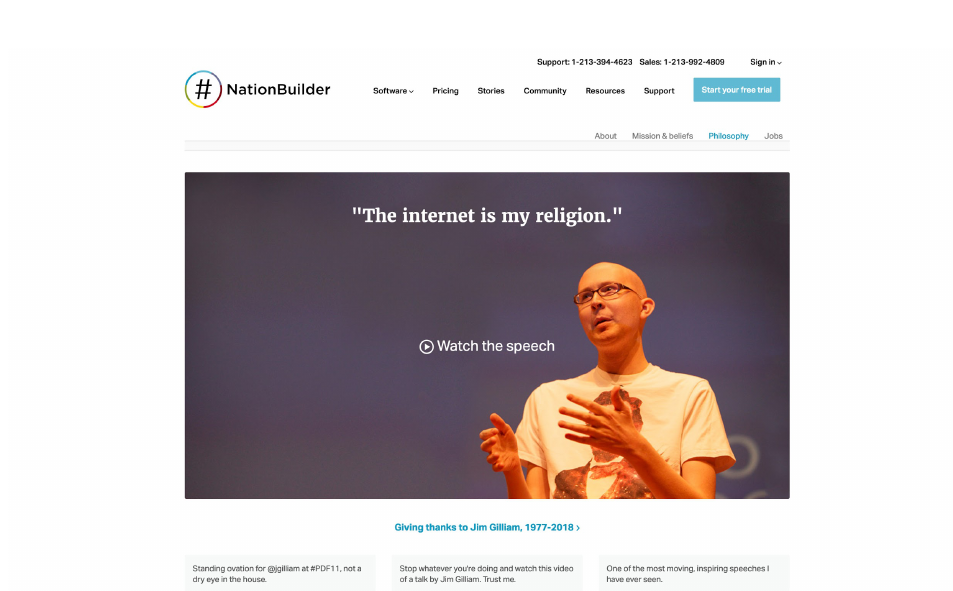
Figure 2: NationBuilder’s philosophy page captured on 8 January